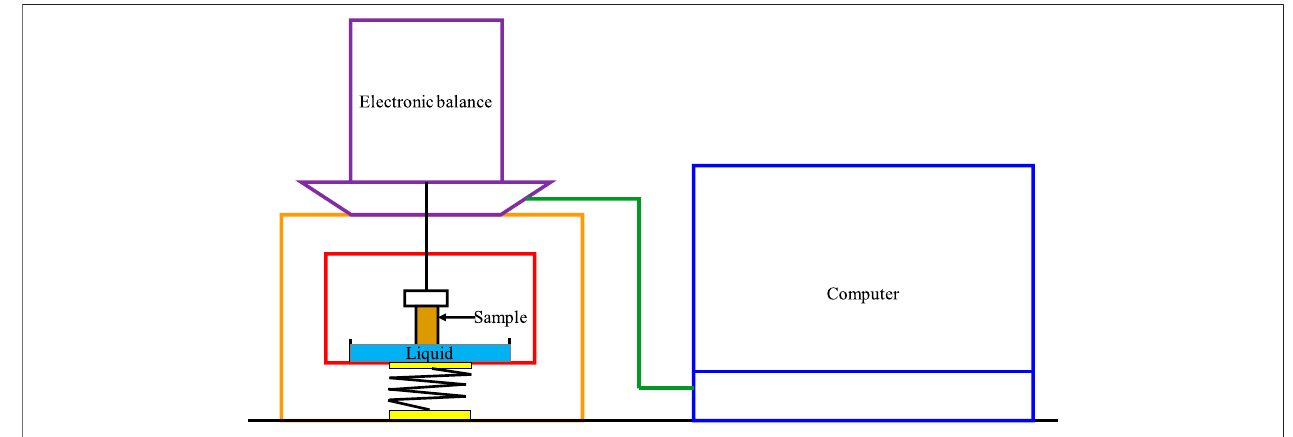
FIGURE 4 | Schematic Diagram of the spontaneous imbibition experiment devices.